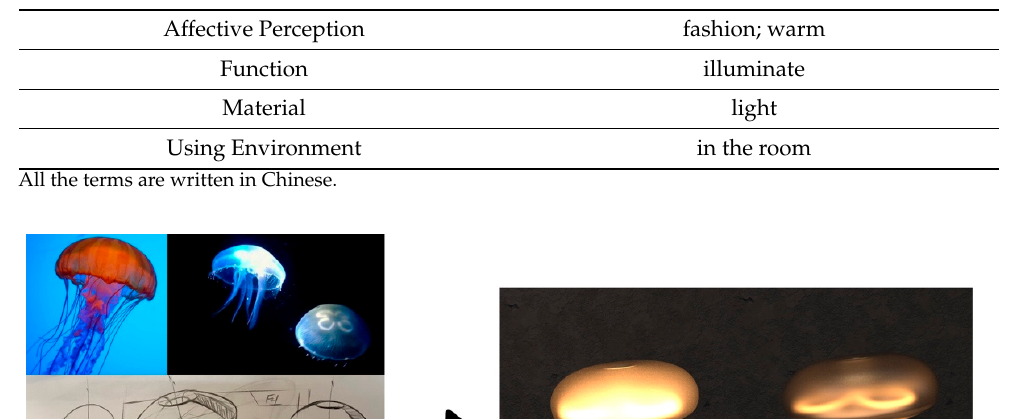
Table 13. Description of night light.